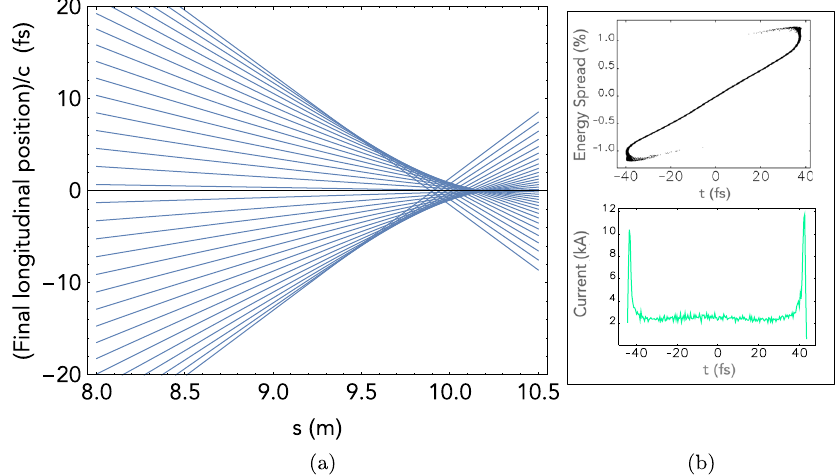
FIG. 3. Electron trajectories through a chicane in s – z plane, showing how the electron trajectories overlap in a caustic at the extreme values of z (i.e., at the head and the tail of the bunch). (b) Typical phase space distribution and corresponding current profile seen at the end of a strong bunch compressor [equivalent to s ¼ 9 . 5 m in